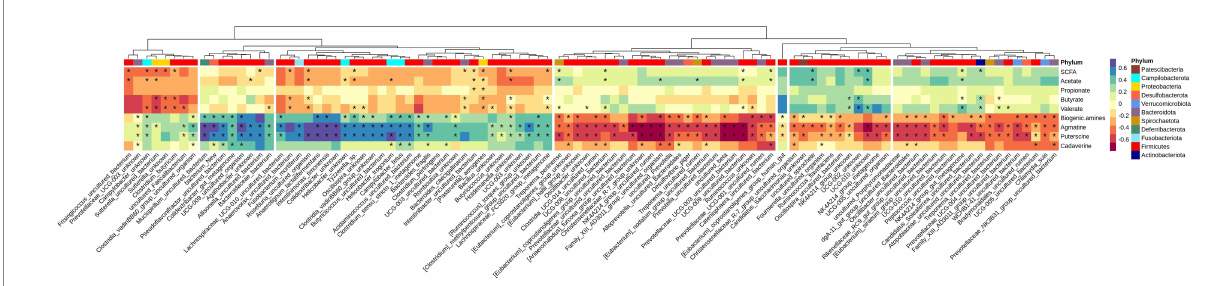
FIGURE 5 Heatmap of Spearman’s rank correlation coefficient ( r s ) between the top 100 abundant species and SCFA and biogenic amines in all segments. Columns are clustered based on the standard deviations between species abundances, i.e., those with lower deviation are clustered together. Species are color-labeled with their correspondent phyla and significant associations are labeled with